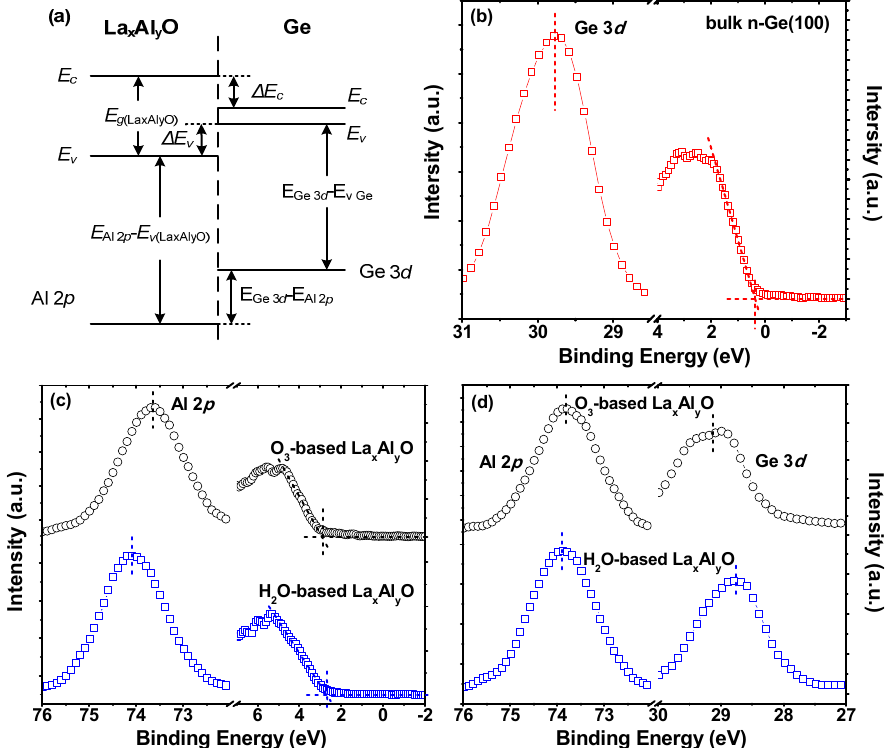
Figure 3. ( a ) schematic of band energy alignment diagram for a La x Al y O/Ge structure; XPS core level spectra of ( b ) Ge 3 d and valence band for bulk clean n-Ge(100); ( c ) Al 2 p and valence band for 10 nm La x Al y O films; and ( d ) Al 2 p and Ge 3 d for 5 nm La x Al y O films on n-Ge(100). The corresponding conduction band offset (CBO, Δ E c ) between La x Al y O and Ge can be obtained by Equation (2):